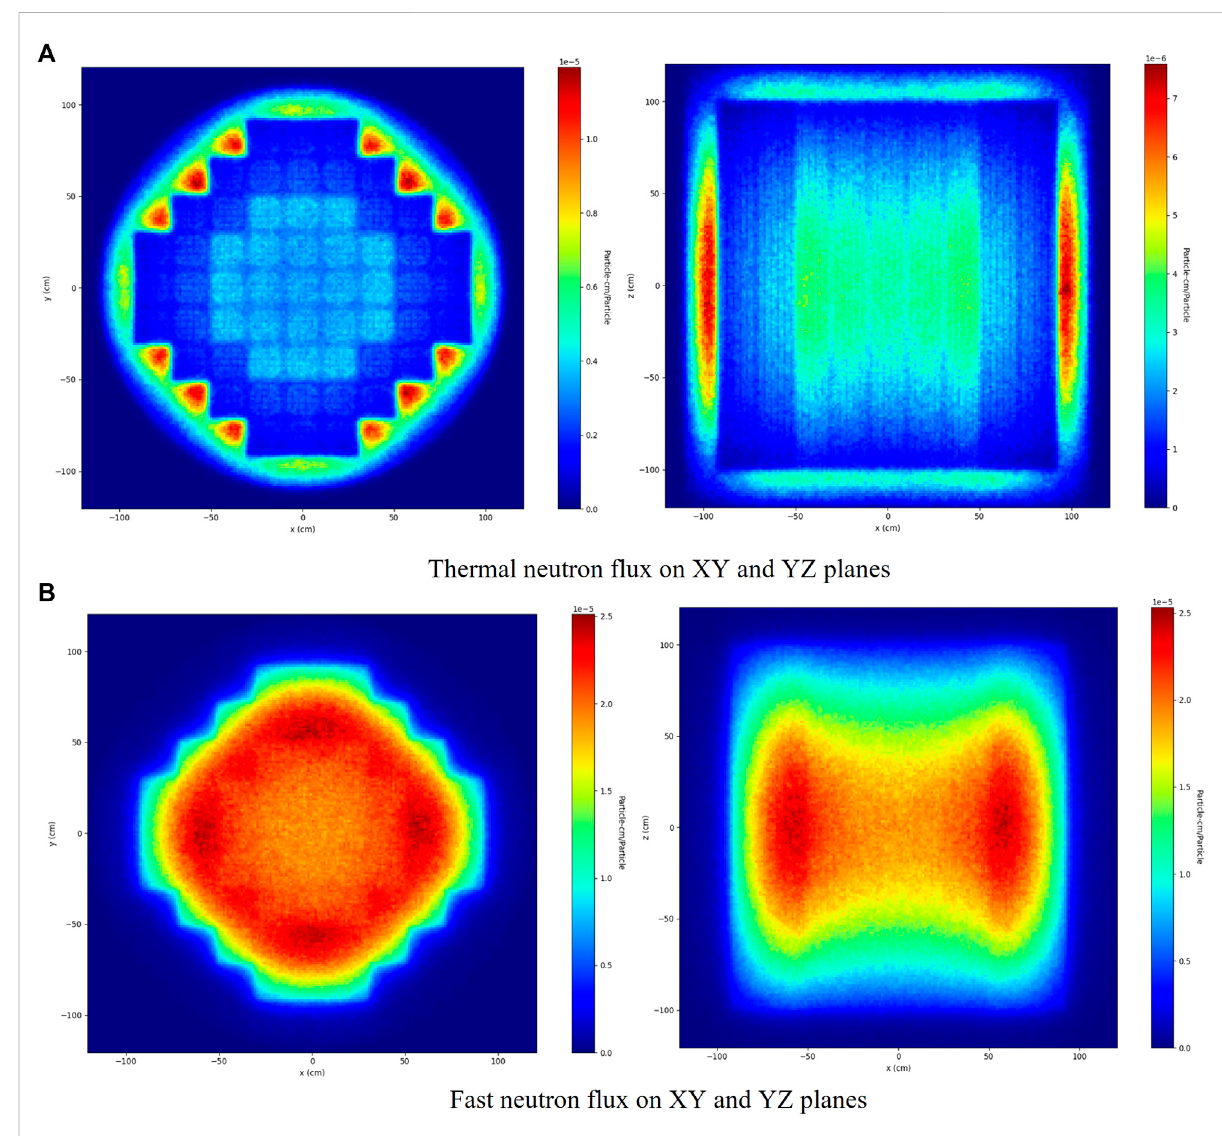
FIGURE 7 The slices of 3D mesh (A) thermal and (B) fast neutron fl ux tallying